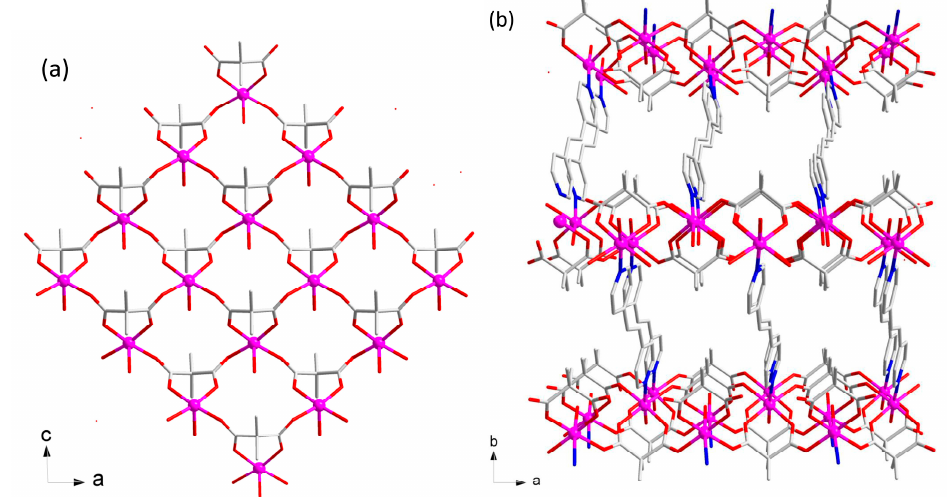
Figure 2. ( a ) View of the 2D layer of Co-(µ 3 -Me 2 mal) in the crystallographic ac plane, ( b ) view of the pillared-layer 3D structure of compound 1 with 1D channels along the c axis. The H atoms have been omitted for clarity.